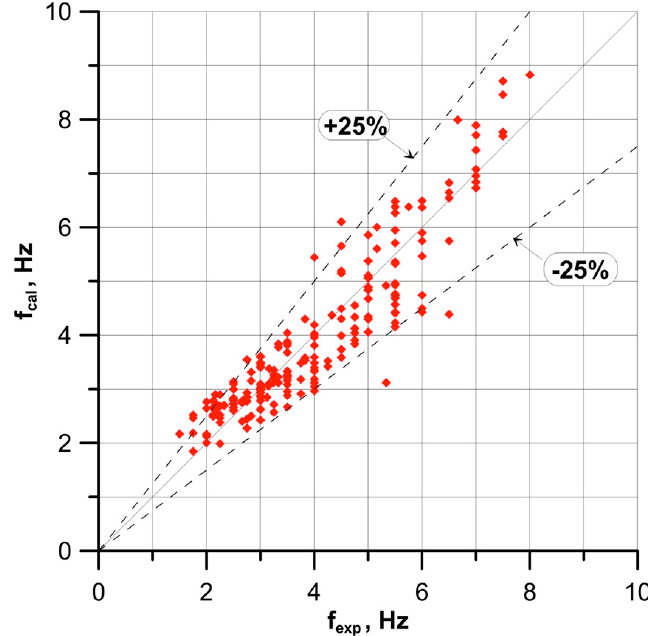
Figure 10. Comparison of measured and calculated values of wave frequency accompanying two-phase gas-very viscous liquid flow for relation (14).